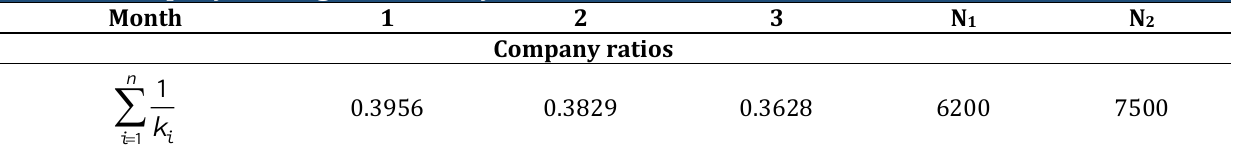
Table 2: Company stuffing and delivery ratios for each month